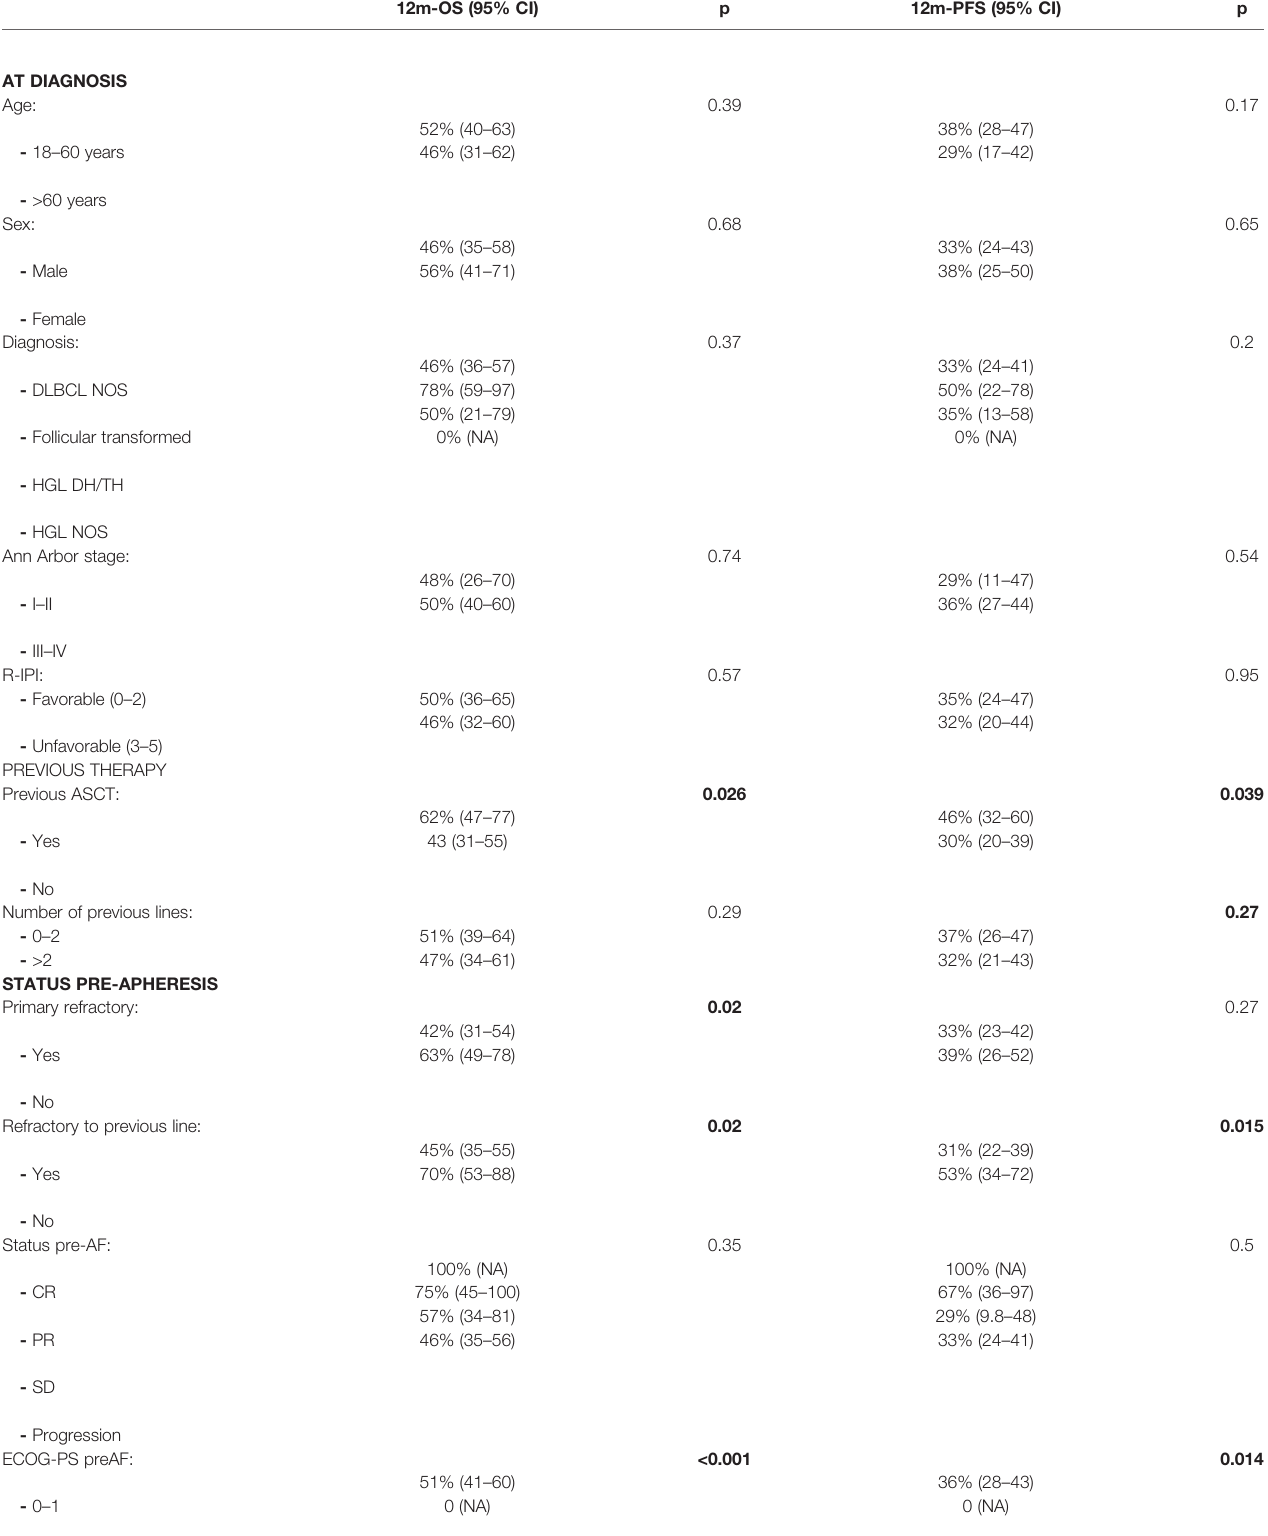
TABLE 4 | Univariable analysis of survival in CAR-T-infused